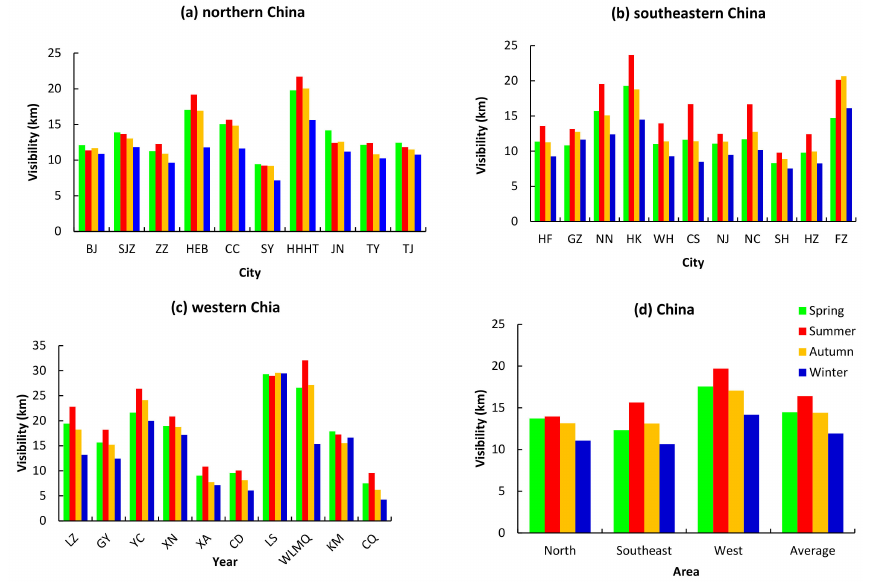
Figure 6. Trends of seasonal average visibilities in China’s provincial capital cities. ( a ) Northern China; ( b ) southeastern China; ( c ) western China; ( d ) average value of